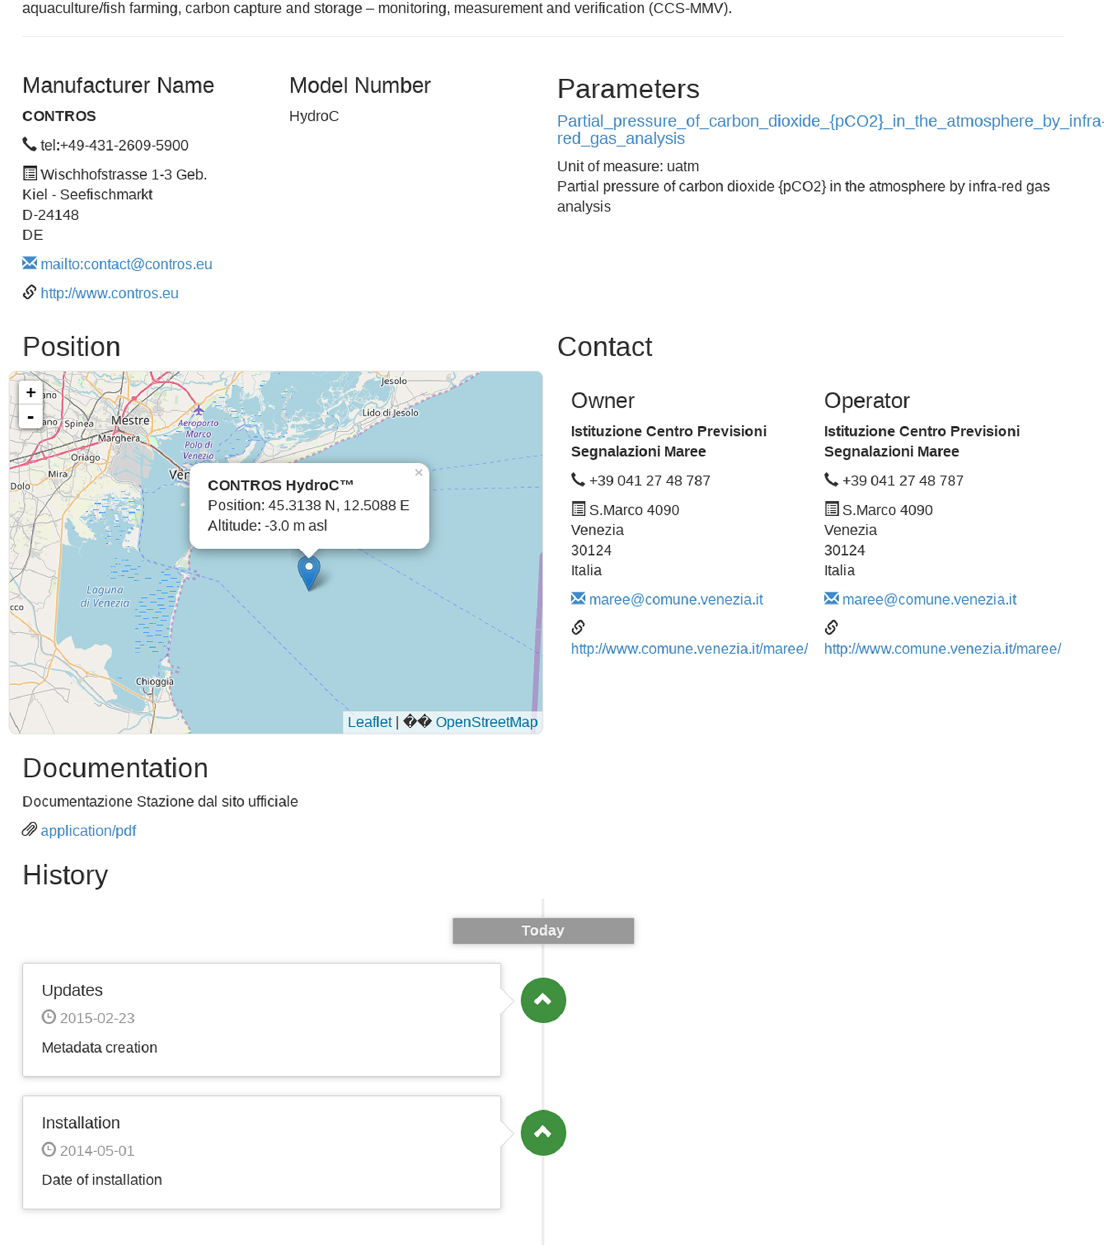
Figure 6. Example of the sensor description provided by GET-IT. Information about manufacturer, owner and operator contacts, measured parameters, position, documentation, and history are displayed. Base map credits: © OpenStreetMap contributors 2019. Distributed under a CC-BY-SA